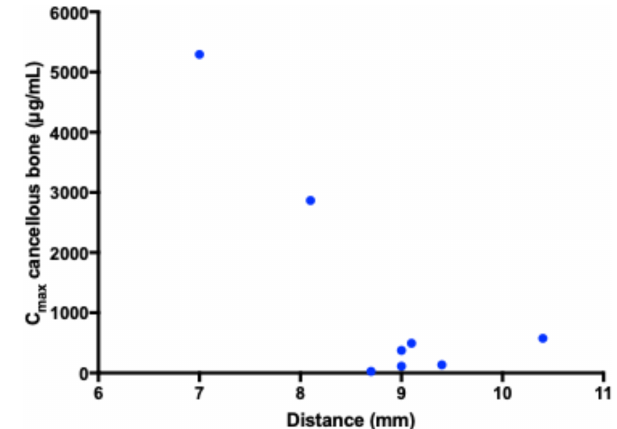
Figure 4. Correlation between the distance from the intraosseous cannula and the adjacent cancellous bone drill hole with the peak drug concentration. No correlation was